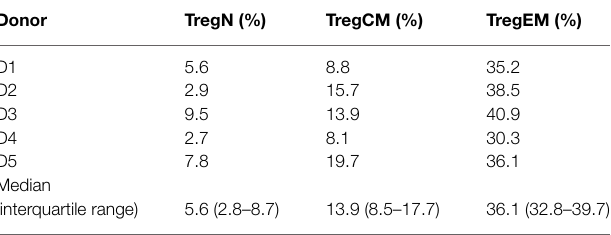
TABLE 2 | Coverage of the TCR repertoire by the top 20 clones in each Treg subset repertoire as shown by next-generation sequencing. Donor TregN (%) TregCM